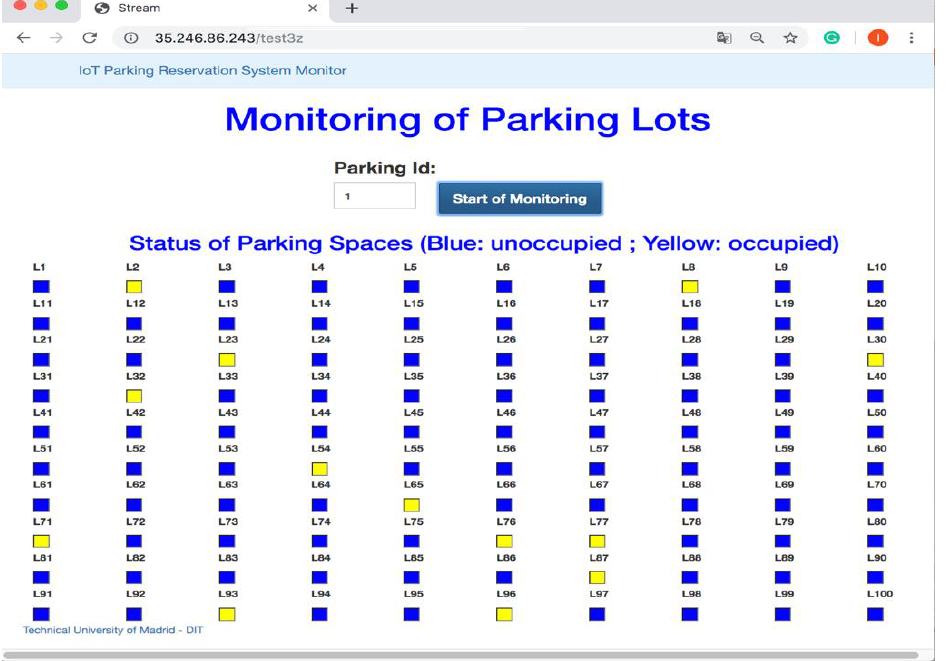
Figure 10. Monitoring service.